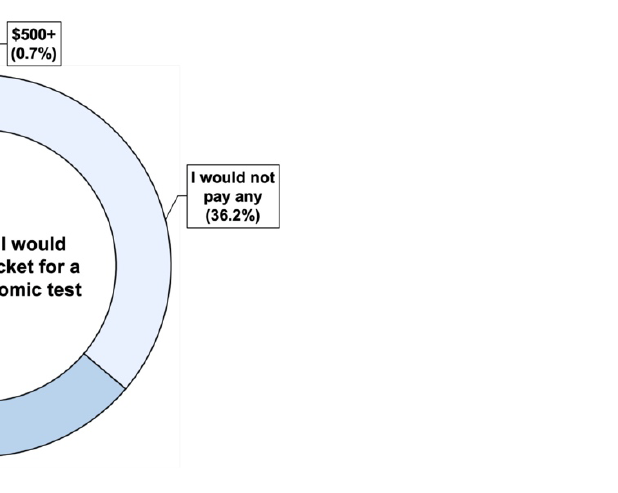
Figure 4. The expected out-of-pocket spending on pharmacogenomic (PGx) testing among survey respondents.